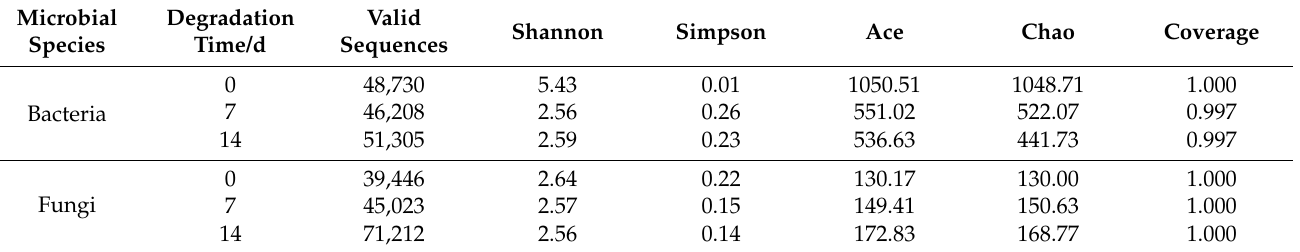
Table 3. Changes in the abundance and diversity of bacteria and fungi during the degradation of liquid